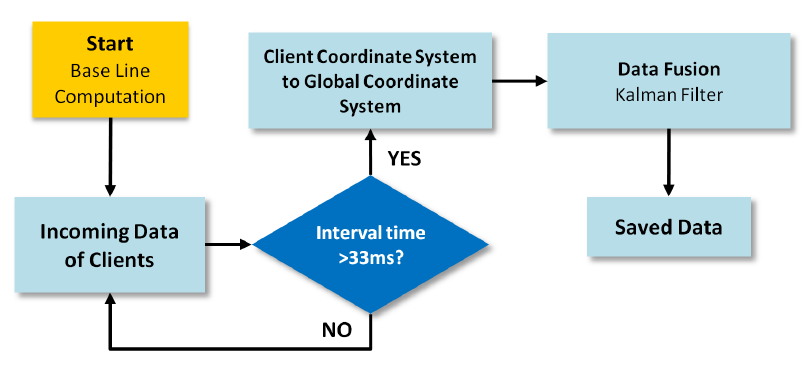
Figure 3. Server flowchart.